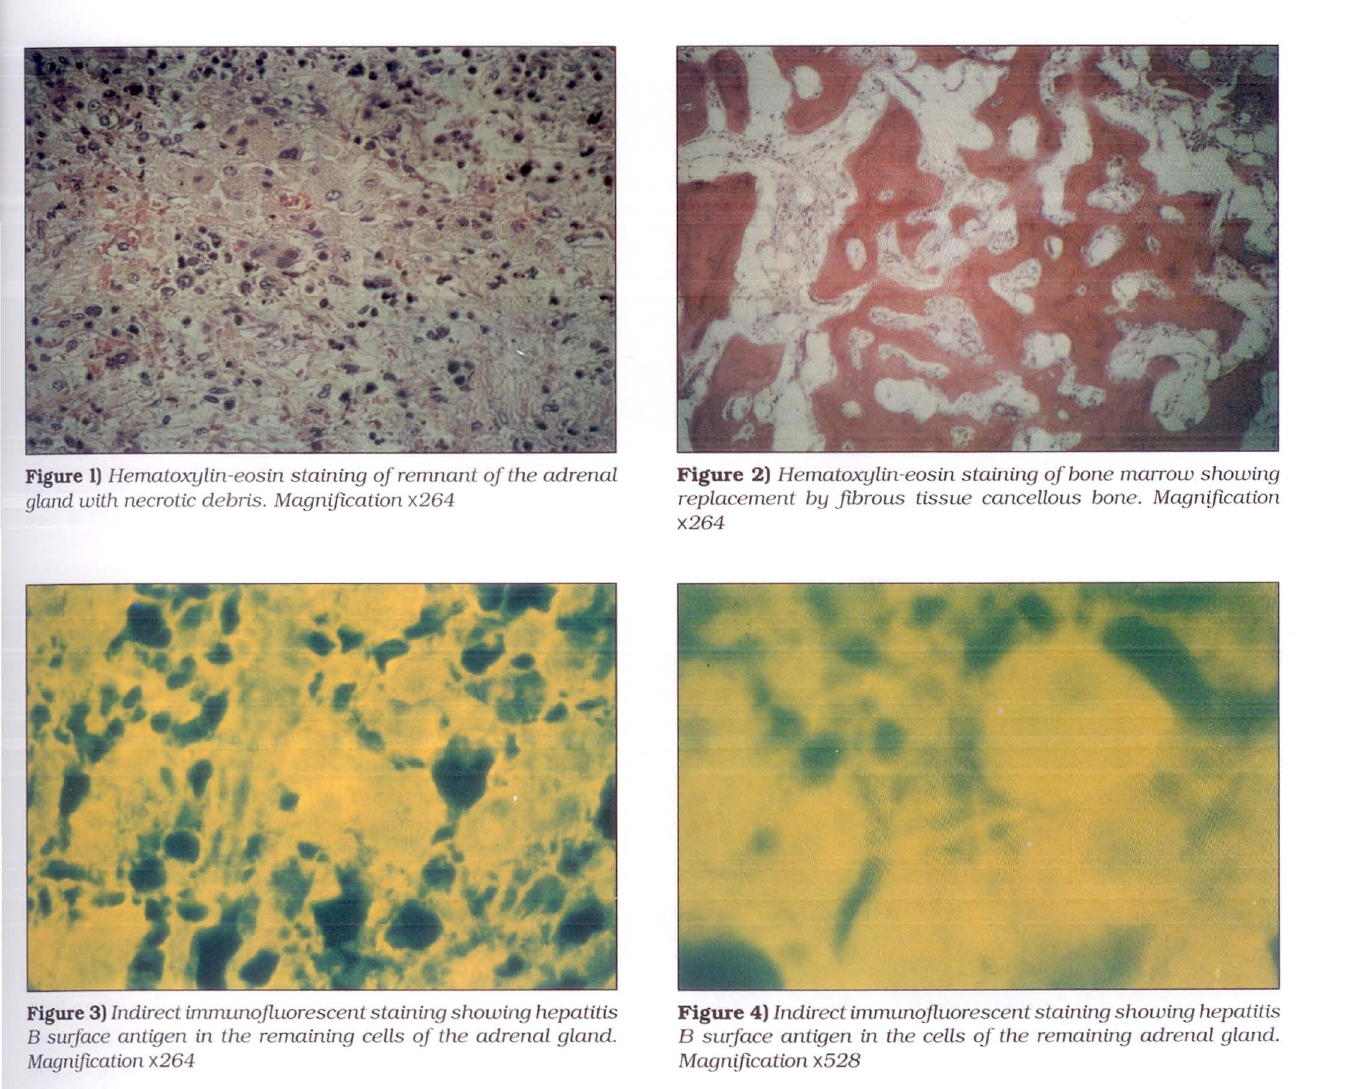
Magnijication x264